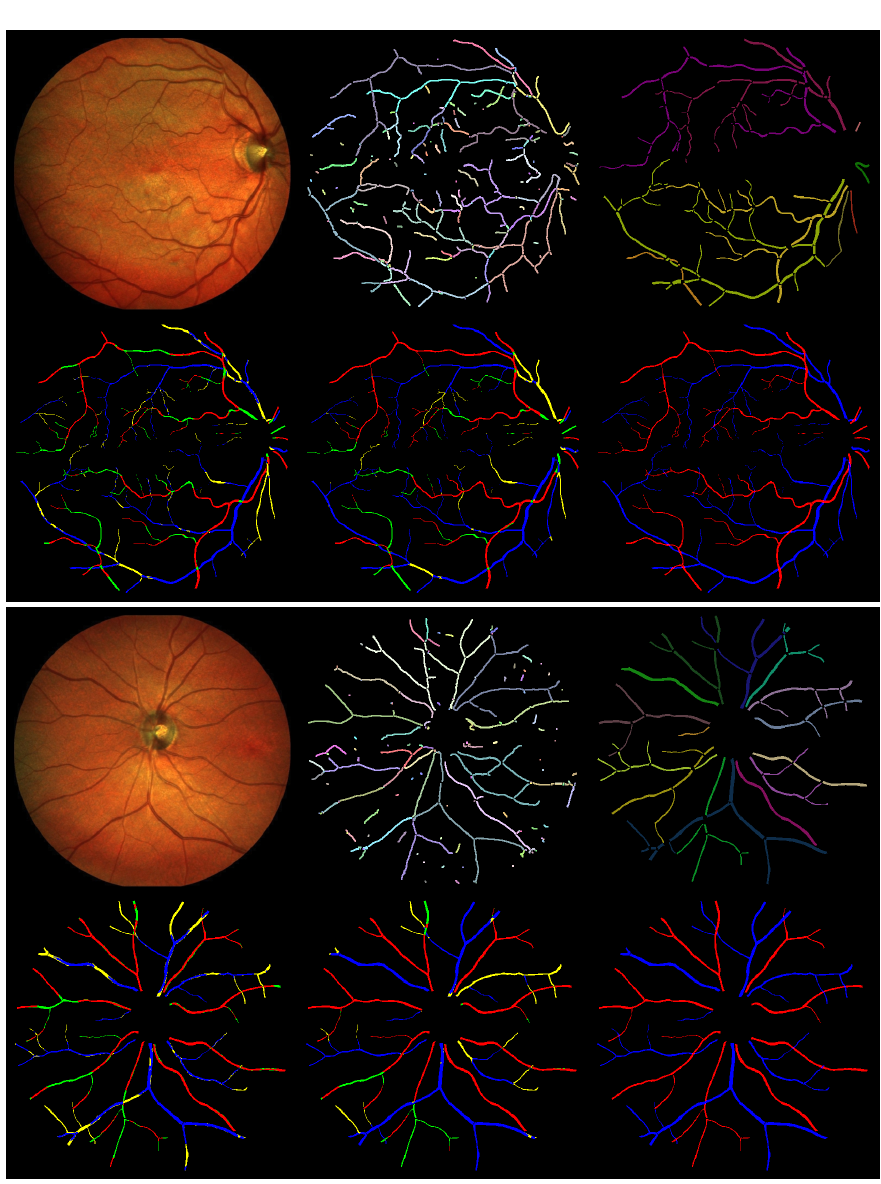
Figure 6. Two example results from the IOSTAR dataset. The six images for a single case are, in row- major order beginning from the top-left, the original input image, estimated topology of the proposed method, GT annotation of the topology, pixelwise AV classification result, tree-wise classification result of the proposed method, and AV GT annotation. Different colors in the topology GT represent separate trees. In each result, correctly classified arteries and veins are marked as red and blue, respectively. Pixels incorrectly labeled as veins are in green, while those incorrectly labeled as arteries are in